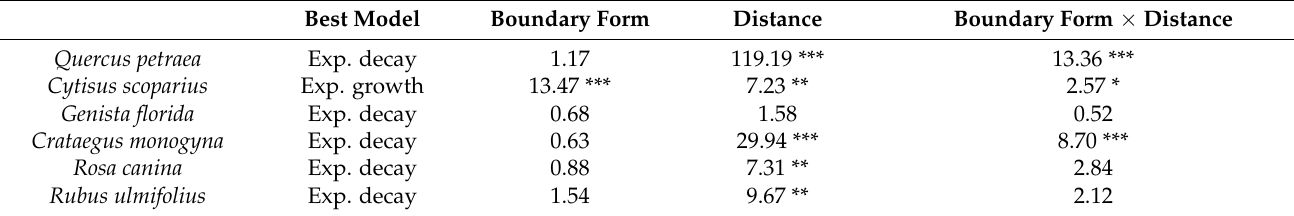
Table 3. Results of Linear Mixed Models (LMM) describing how the density of main woody colonizers of the mines varied according to boundary form, distance to the forest edge, and their interaction. F-values of fixed effects and their